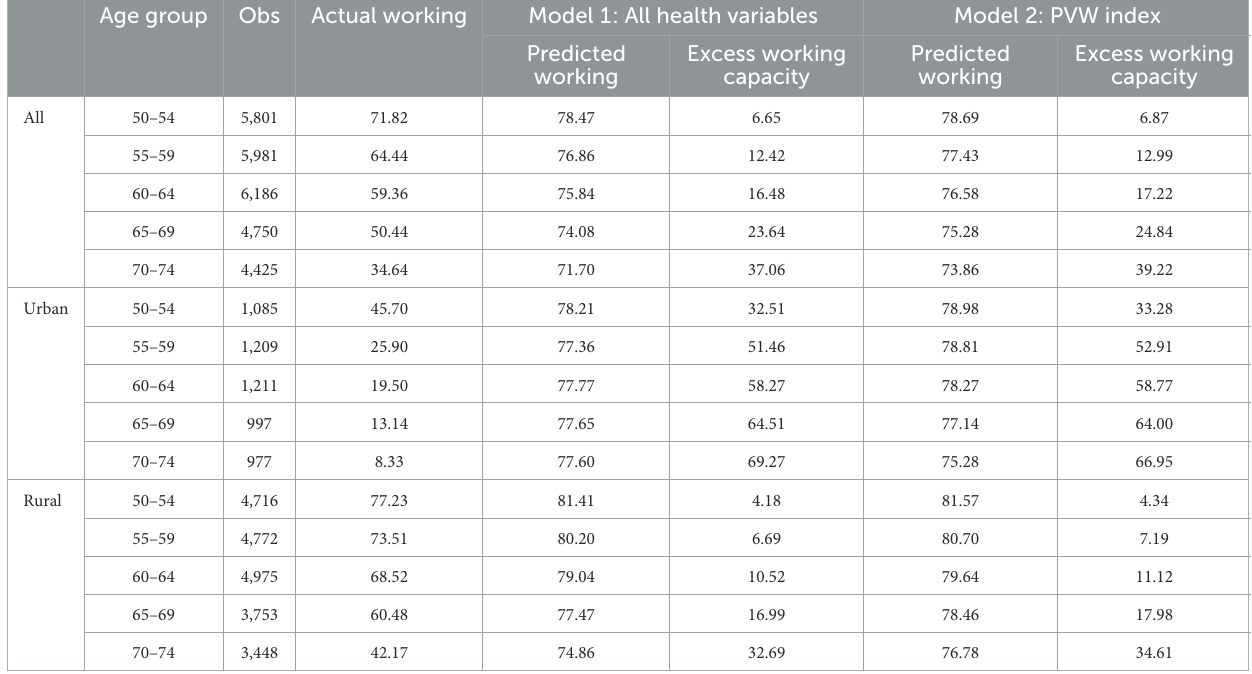
TABLE 4 Calculation of excess work capacity (%): all 45–49 women as benchmark. Age group